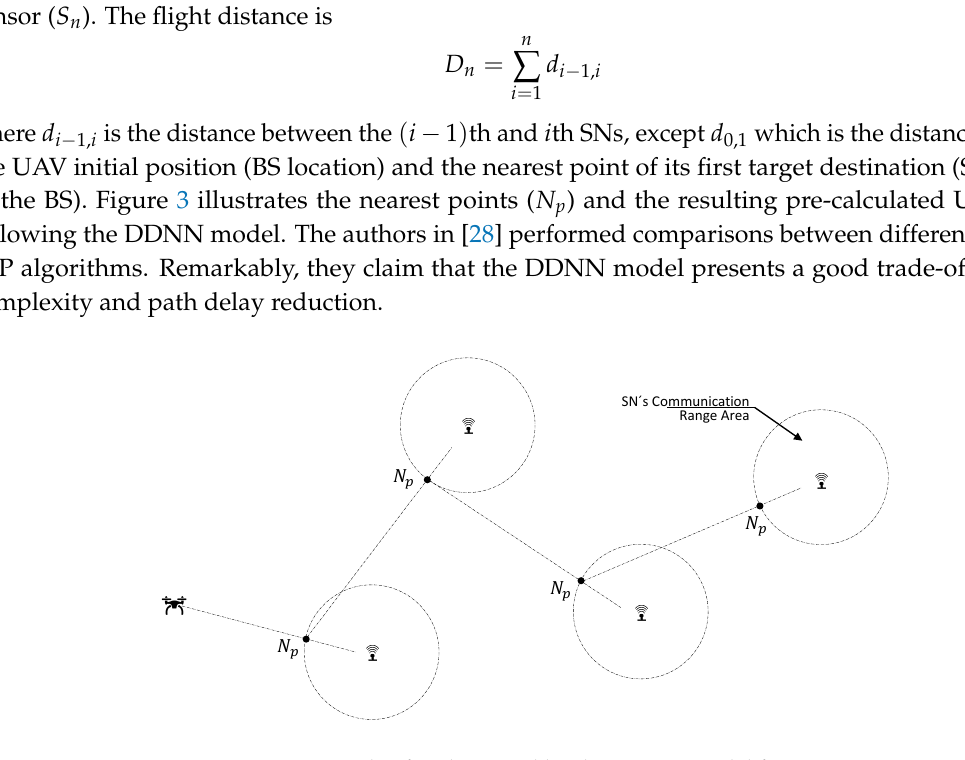
Figure 3. Example of path created by the DDNN model for